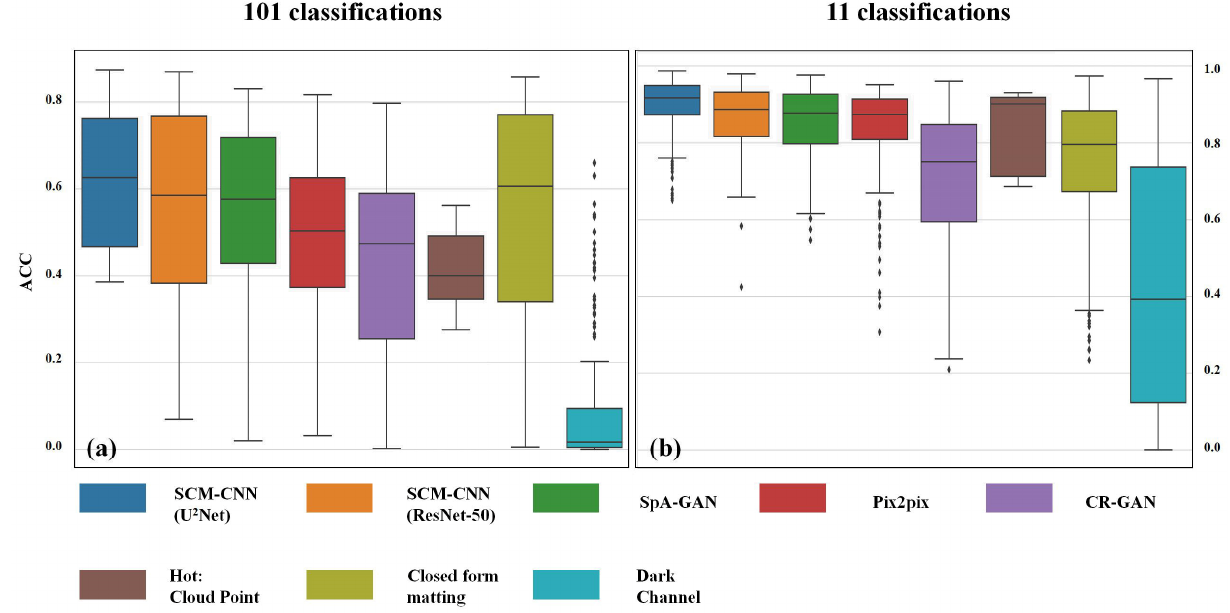
Figure 7. The results of Figure 6a are transformed into 101 ( a ) and 11 classes ( b ). We divided the predicted cloud opacity results into 101 classes and 11 classes based on intervals such as 0–1 and obtained the prediction pixel accuracy based on matching the prediction results to them. The Hot methods utilized 20 sets of image slices, whereas the others utilized 640 sets of image slices. Table 2. Comparison of classification metrics for multiple cloud removal methods. Two metrics were obtained for each cloud removal method, representing the method’s optimal and average values. By comparing multiple methods, we use green and blue to denote the best metrics values obtained by each method.